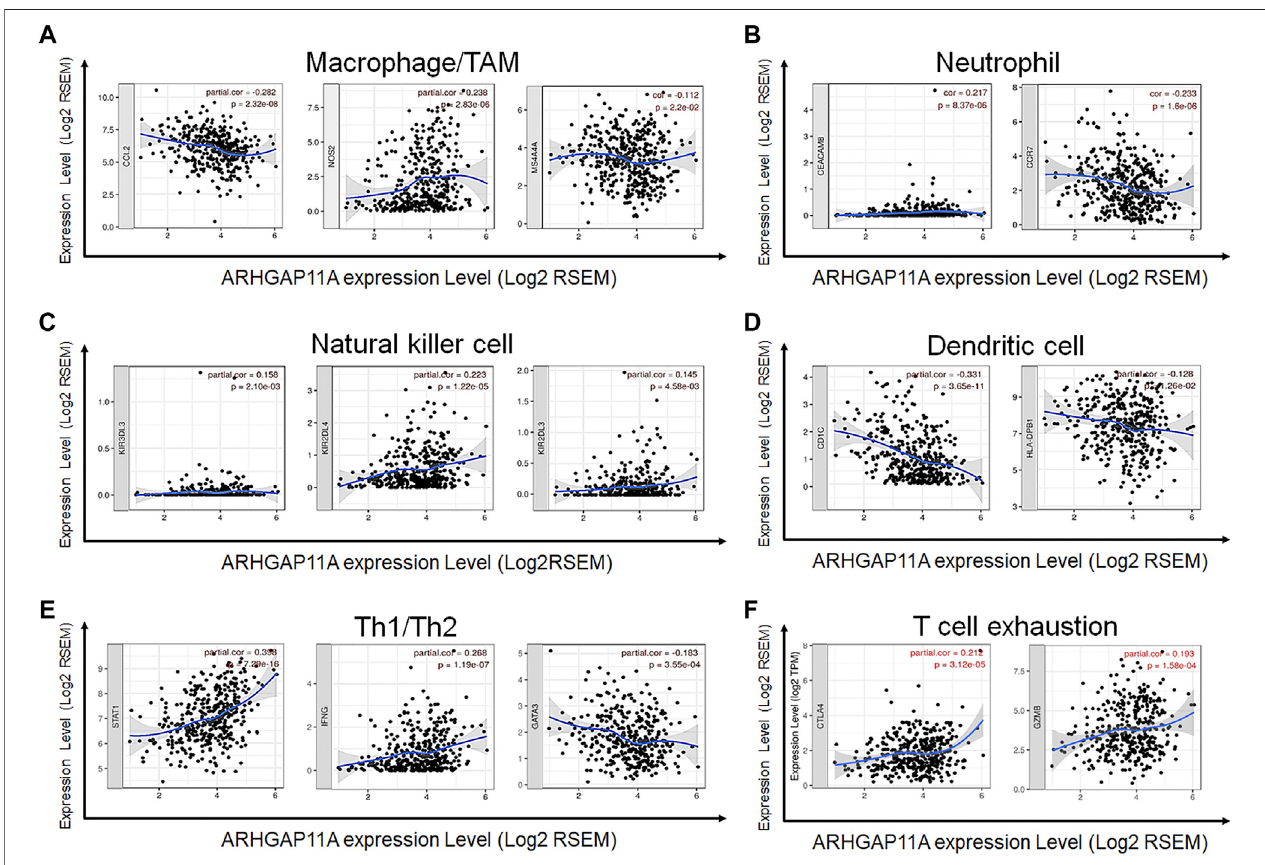
FIGURE4| Correlation betweenARHGAP11A expression andimmunemarkers ingastric cancer. (A) Markers ofmacrophages/TMAs. (B) Markersofneutrophils. (C) Markers of nature killer cells. (D) Markers of dendritic cells. (E) Markers of Th1/Th2 cells. (F) Markers of exhausted T cells.